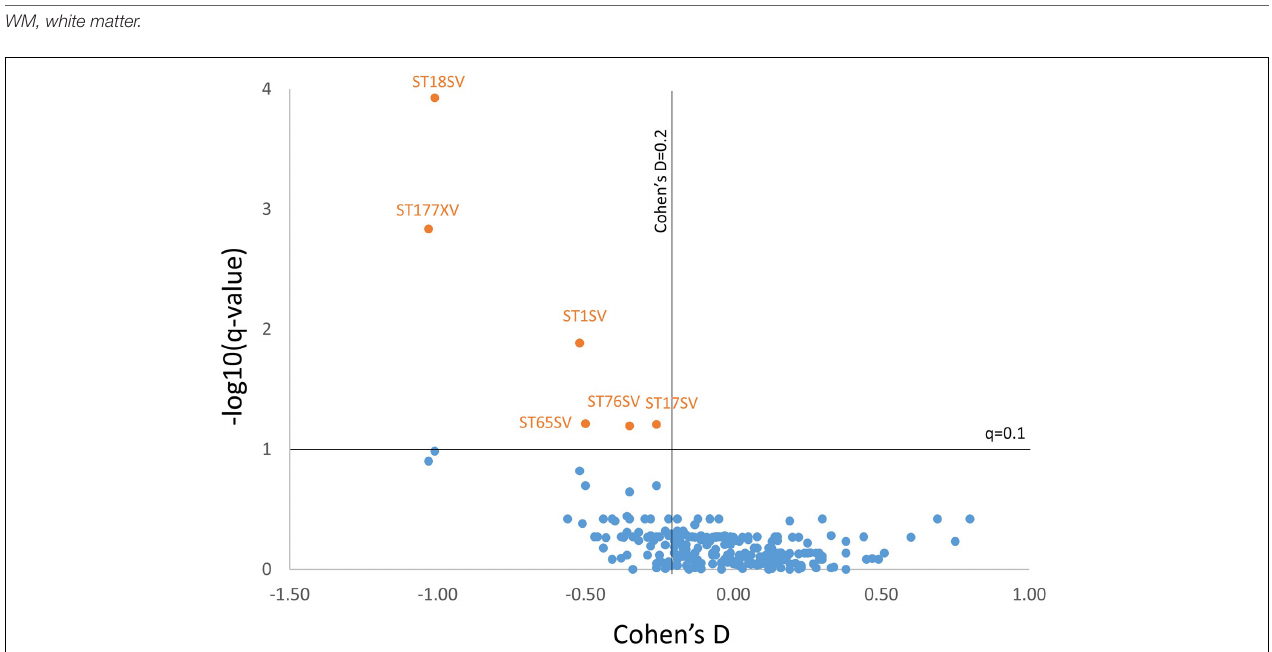
smaller in AD subjects with RHL compared to NHL subjects and had Cohen’s D values above 0.2. These brain regions were the volume of left and right cerebellar white matter, volume of the brain stem, volume of left ventral diencephalon, and the volume of left and right cerebellar cortex (see Figure 1 for volcano